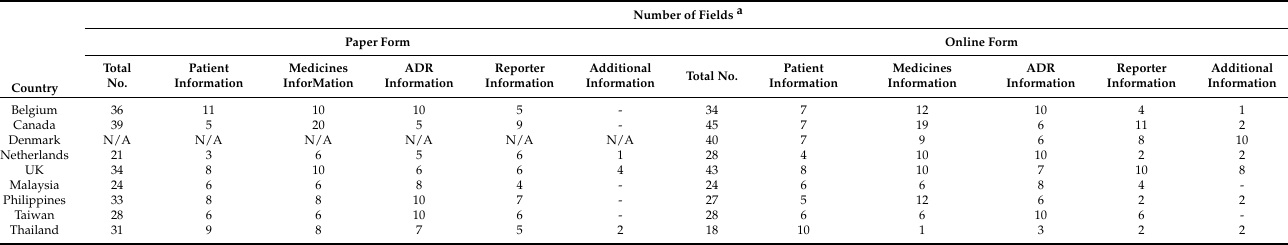
Table 5. Details of patient reporting form.